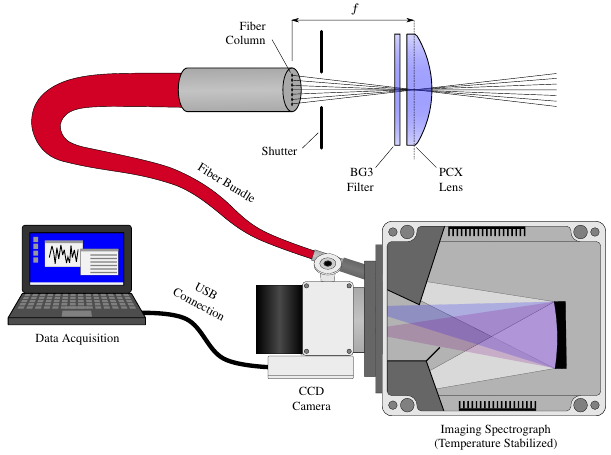
Figure 5. Setup of HAIDI’s forward-looking telescope (pushbroom scanner). The individual fibers of the fiber optics bundle, which con- nects the telescope with the imaging spectrograph, are arranged to a slit on both sides. This leads to 31 simultaneous viewing direc- tions/elevation angles. A mechanical shutter protects the detector from incident light during the readout process. Hardware control and data acquisition is done by a computer which is connected via